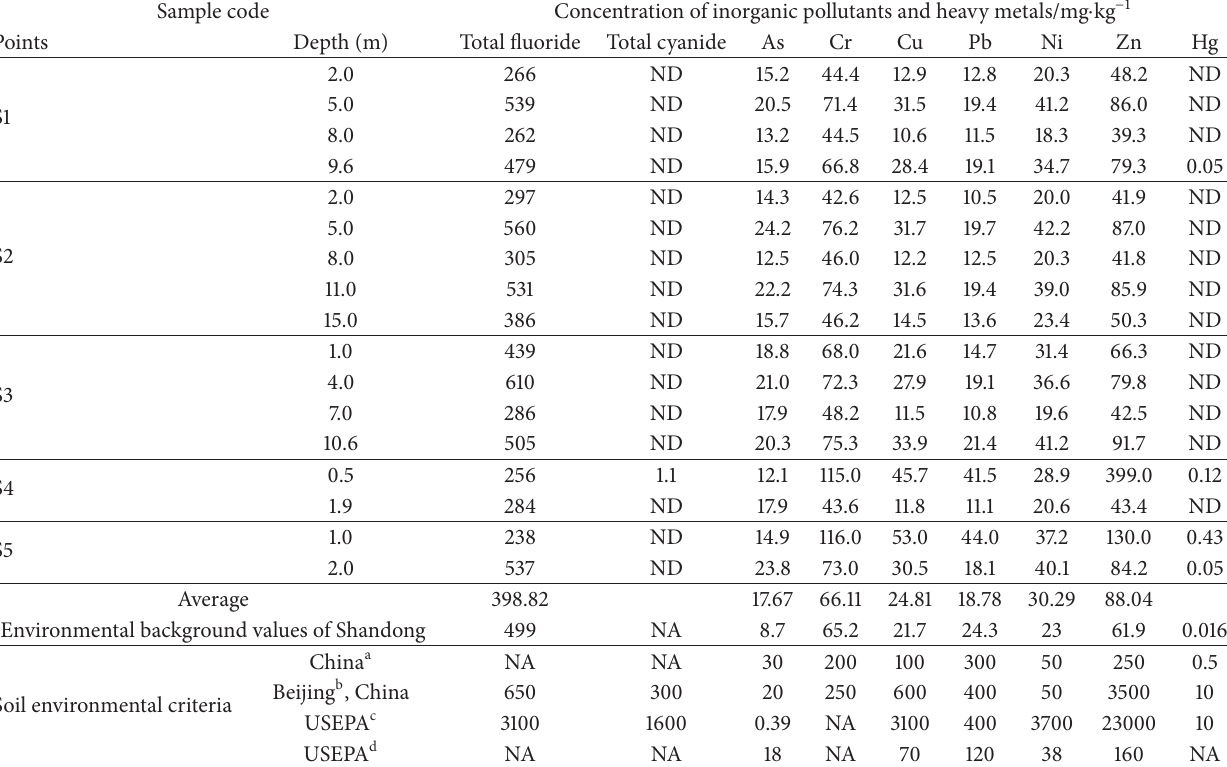
Table 4: Pollution status of inorganic pollutants and heavy metals at the open